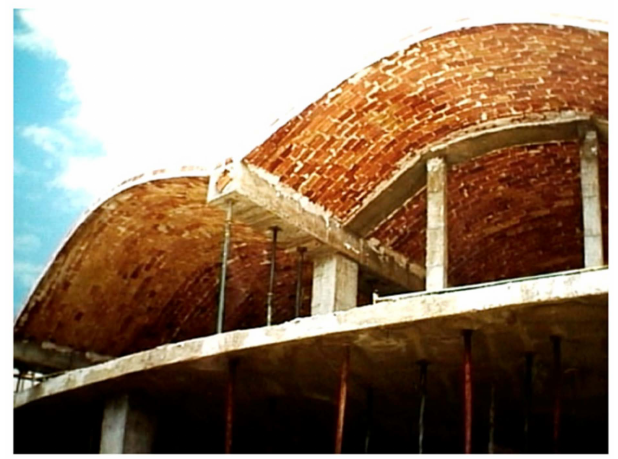
Figure 3. Vault pieces constructed in hollow thin brick by the authors, in